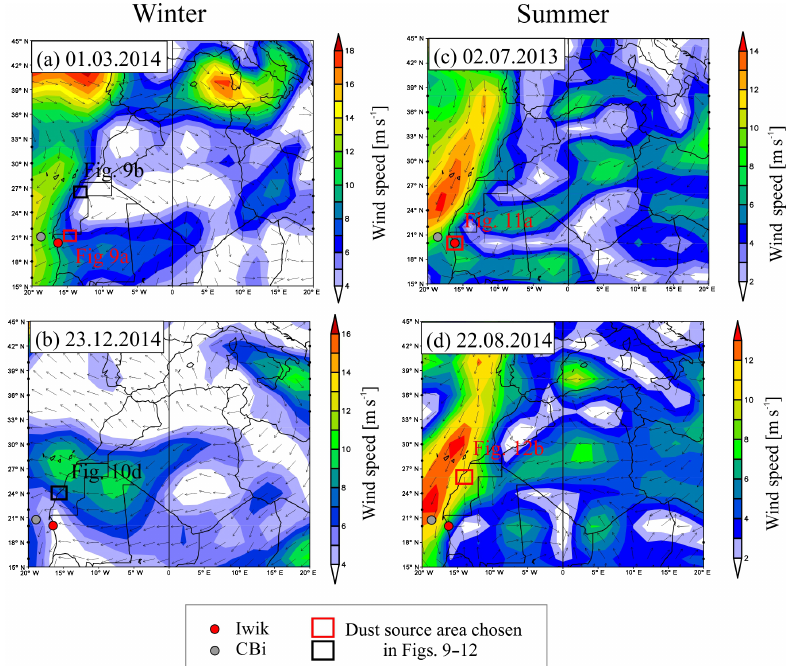
Figure 13. Six-hourly composite mean wind vectors and speed at 1000mb for selected days including a dust storm event during winter (a–b) and summer (c–d) . Furthermore, the dust source area that was identified for the individual dust storm event using the back trajectory of the day with the dust storm is